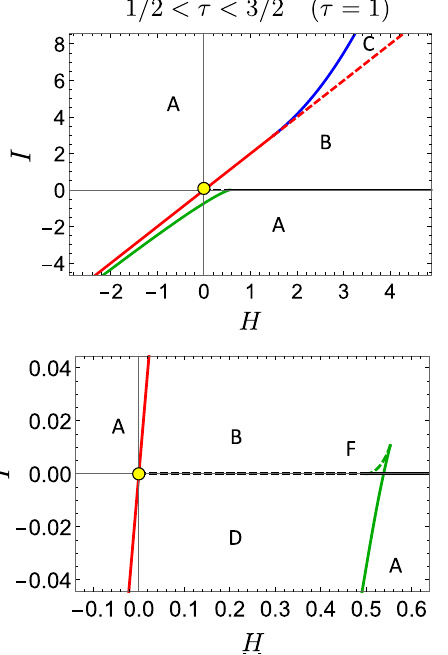
FIG. 15. Bifurcation diagram Σ for the insert strength value τ ¼ 1 , dividing the ð H; I Þ plane into six distinct regions. (Upper) Default view. (Lower) Scaled-up view near ð H; I Þ ¼ ð 0 ; 0 Þ , in which the region of type F is visible.